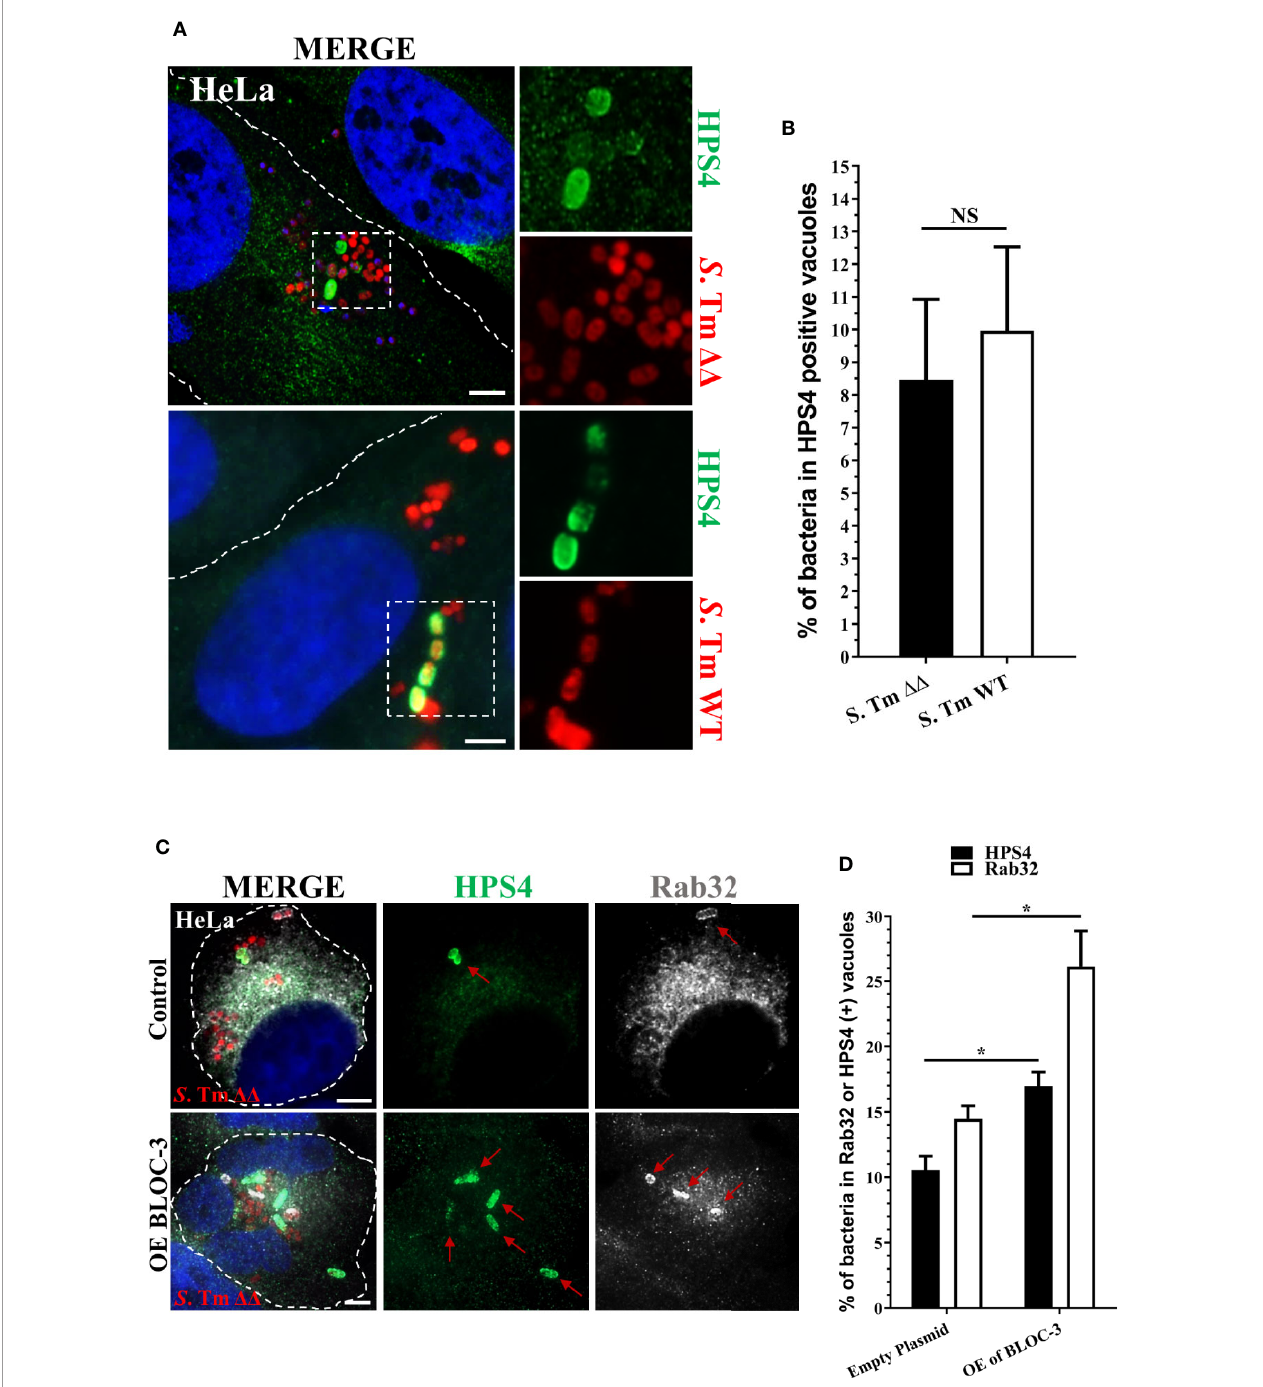
FIGURE 1 | BLOC-3 sub-unit HPS4 is recruited to the Salmonella -containing vacuoles (SCV). (A) HeLa cells were infected with mCherry S . Typhimurium D gtgE D sopD2 ( DD ) or WT for 2.5 h, fi xed and stained with monoclonal anti-HPS4 antibody (green). (B) The percentage of S . Typhimurium in HPS4-positive vacuoles were analyzed by immuno fl uorescence and the ± standard deviation of three independent experiments are shown. At least 100 bacteria were counted in each experiment. (C) HeLa cells either over-expressing BLOC-3 complex or empty plasmid (control) were infected with S . Typhimurium D gtgE D sopD2 , fi xed at 2.5-h post- infection and co-stained with anti-HPS4 (green) and anti-Rab32 (gray) antibodies. Images were analyzed using fl uorescence microscopy. (D) The percentage of bacterium in HPS4 or Rab32 positive vacuoles were analyzed by immuno fl uorescence and the ± standard deviation of three independent experiments are shown. (Student ’ s t test; *p < 0.05, NS, Non-signi fi cant), S . Tm, Salmonella Typhimurium; Scale bar: 5 m